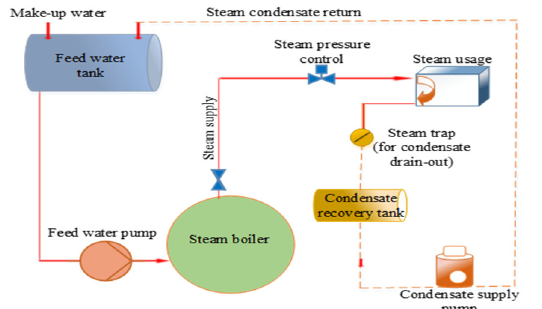
Fig. 5: Schematic diagram of steam condensate